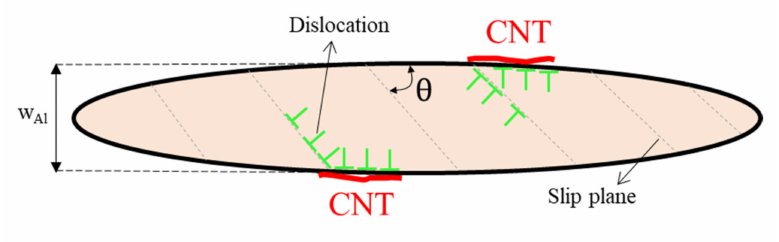
Figure 6. Illustration of the dislocations